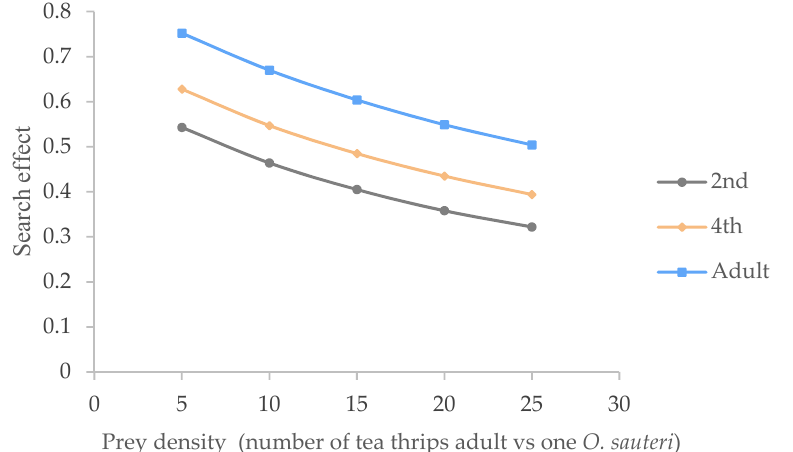
Figure 3. Searching effect of different stages of O. sauteri for adult tea thrips (25 °C).